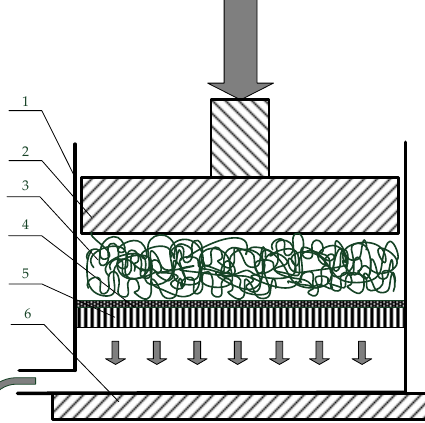
Figure 1. Schematic of the press: cylinder, 2—piston, 3—pulp, 4—mesh, 5—perforated bottom, 6—base.